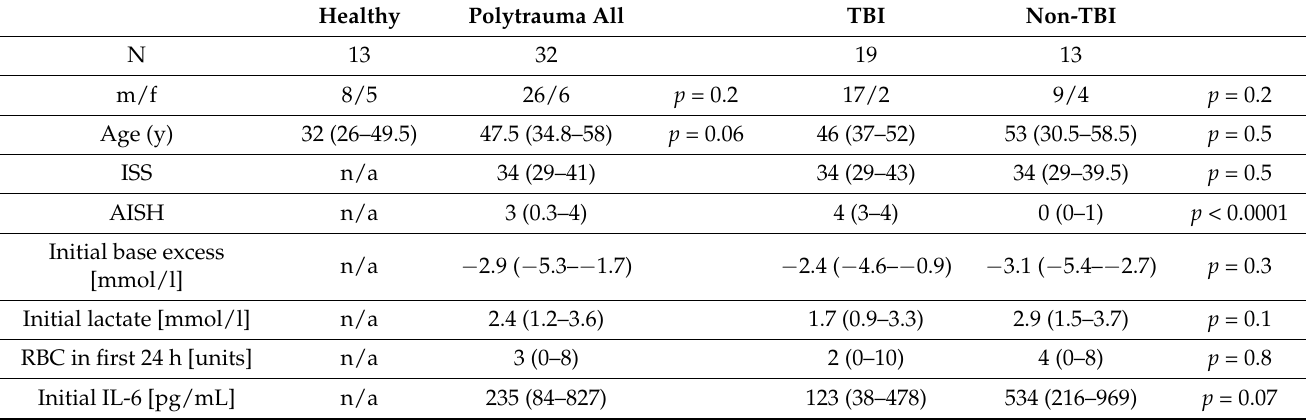
Table 1. Demographic and clinical features of patients and healthy